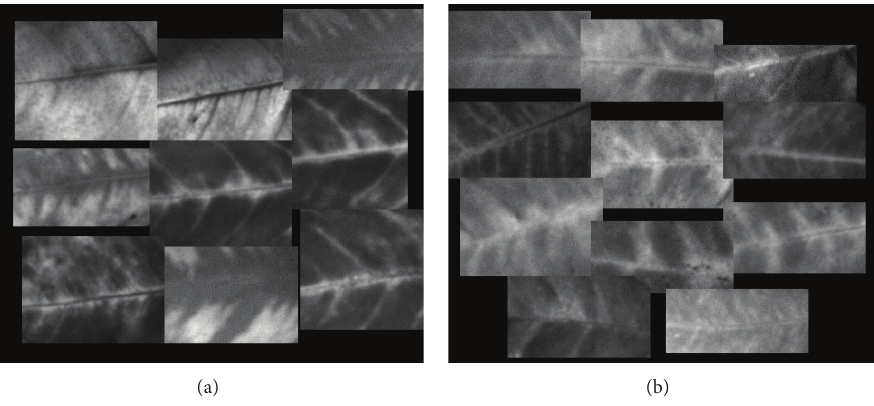
F 3: Segmented images from Brazil (a) and the USA (b).